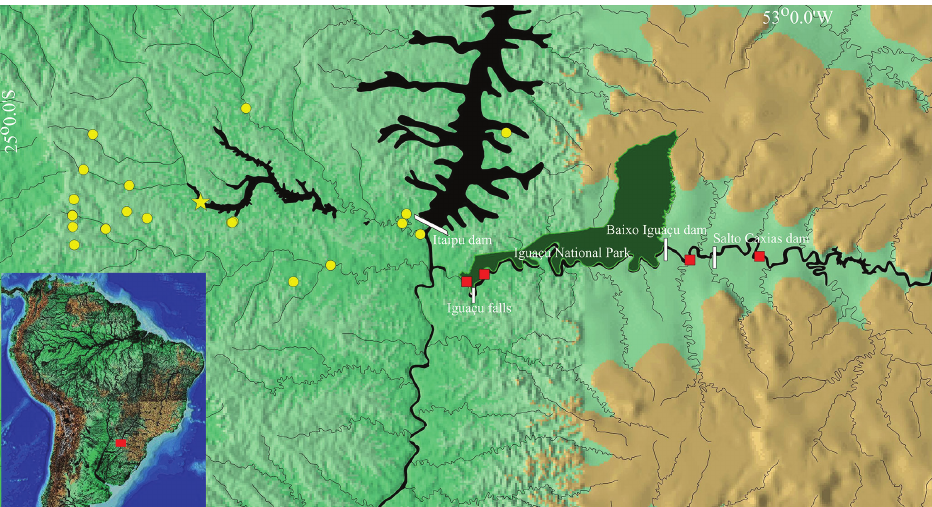
Fig. 1. Partial map of southern South America showing distribution of Gymnogeophagus setequedas . Yellow symbols represent lots of specimens from type-material and additional material housed in Swedish Museum of Natural History. The yellow star marks the type-locality (río Iguazú Reservoir, at Juan E. O’Leary, Paraná River basin, Paraguay). Red squares represent the new specimens discovered from the Iguaçu River basin, Brazil. White lines indicate physical barriers to